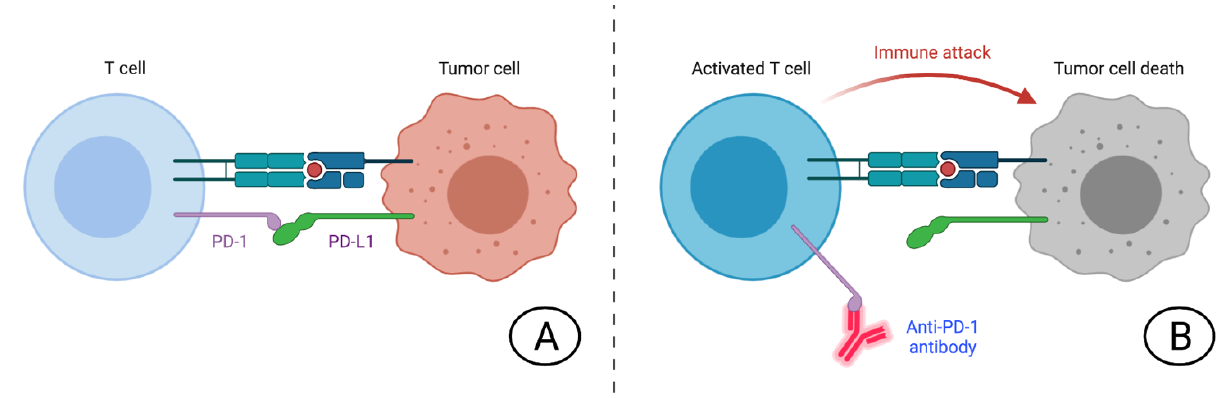
Figure 1. Schematic figure representing the mechanism of action of immune checkpoint inhibitors: ( A ) Immune checkpoint inhibits T-cell activation; ( B ) PD-1 inhibitors lead to T-cell activation.